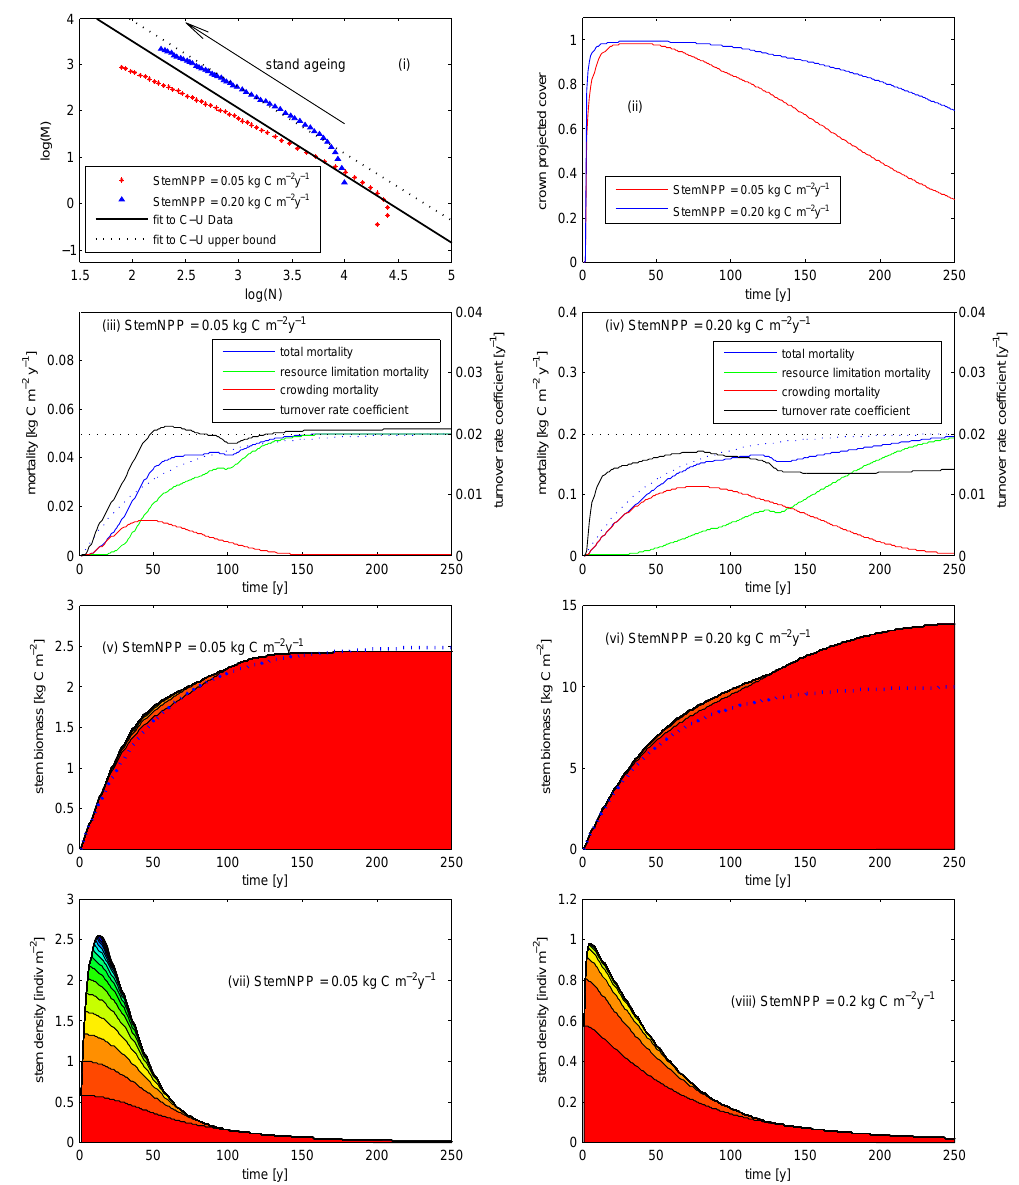
Figure 6. POP dynamics, as illustrated by undisturbed patch simulations at low and high extremes of annual stem increment (StemNPP = 0.05kgCm − 2 year − 1 and StemNPP = 0.20kgCm − 2 year − 1 ) . (i) Biomass–density plot, showing the ageing trajectories of each patch (every 5th year plotted). Linear fits to the C–U data and their upper bound are shown for reference: (ii) time course of crown projective cover for each patch; and (iii) and (iv) time course of mortality, its components and turnover rate coefficient for patches with low (iii) and high (iv) annual stem increments. Dotted lines (blue) represent mortality based on a fixed turnover rate (dotted black line) of 0.02 year − 1 , and (v) and (vi) time course of stem biomass for patches with low (v) and high (vi) annual stem increments. Solid lines indicate contributions form different cohorts. Dotted lines represent biomass accumulation assuming a fixed turnover rate of 0.02 year − 1 , and (vii) and (viii) time course of stem density for patches with low (vii) and high (viii) annual stem increments. Solid lines indicate contributions from different cohorts.